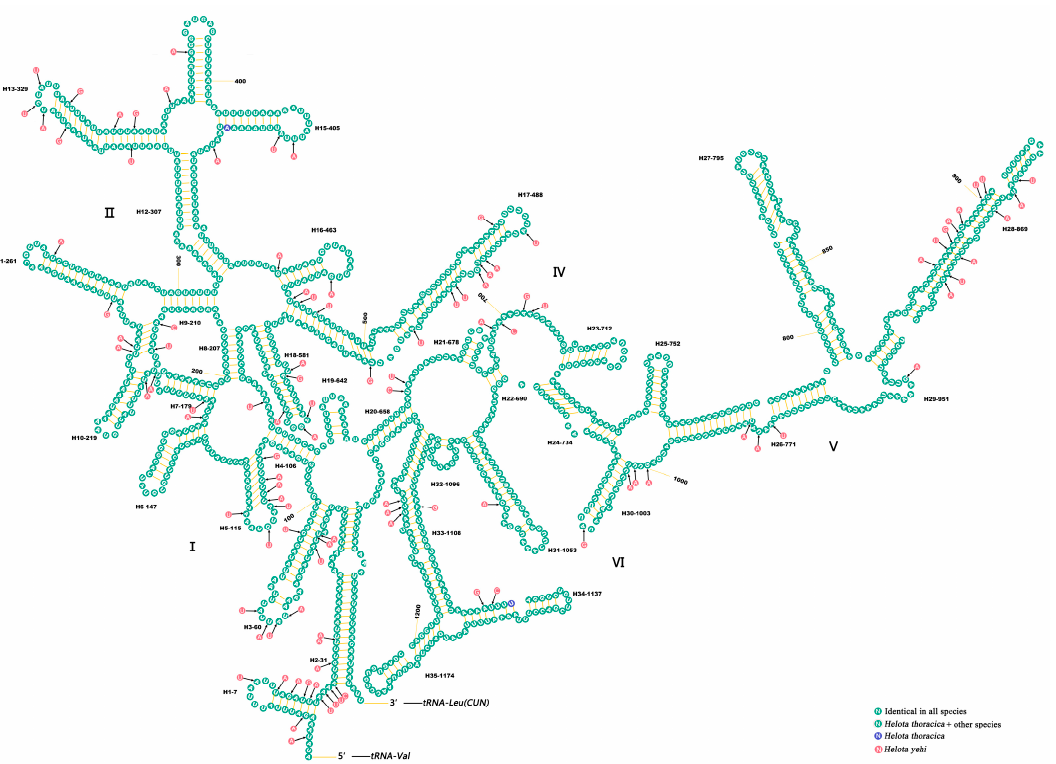
Figure 7. Predicted rrnL secondary structure in the mt genome of H. thoracica and H. yehi . Roman numerals refer to domain names. H. thoracica is the base map and base changes in H. yehi are presented in circles with blue ( H. thoracica ) and gray ( H. yehi ) colors.